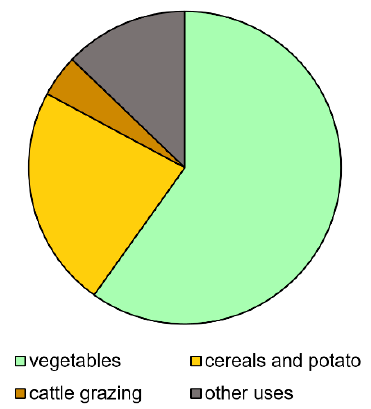
Figure 2. Land use in farms of chili pepper producers in Villa Prat and Palmilla, Maule, Chile.